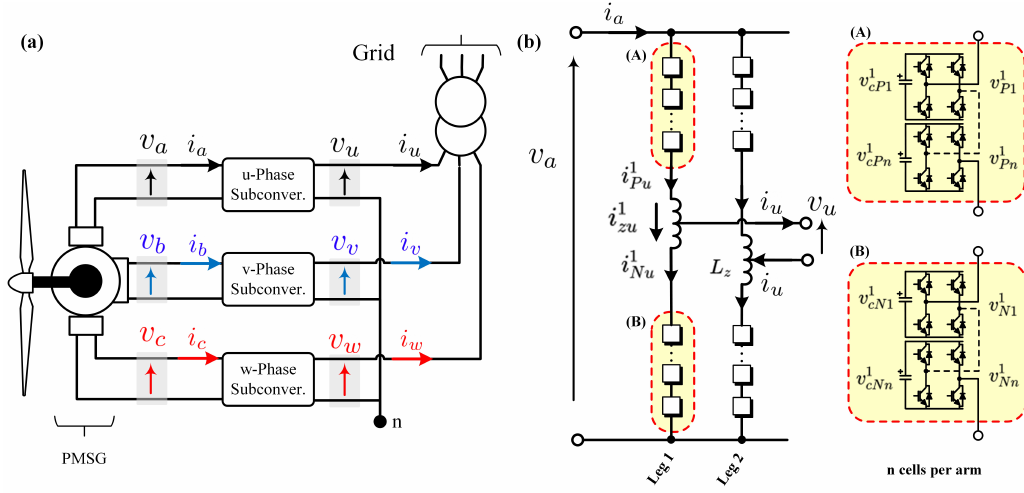
Figure 8. MMCC topology proposed in [90] for grid-integration of multi-channel generators. ( a ) WECS application. ( b ) Topology details.